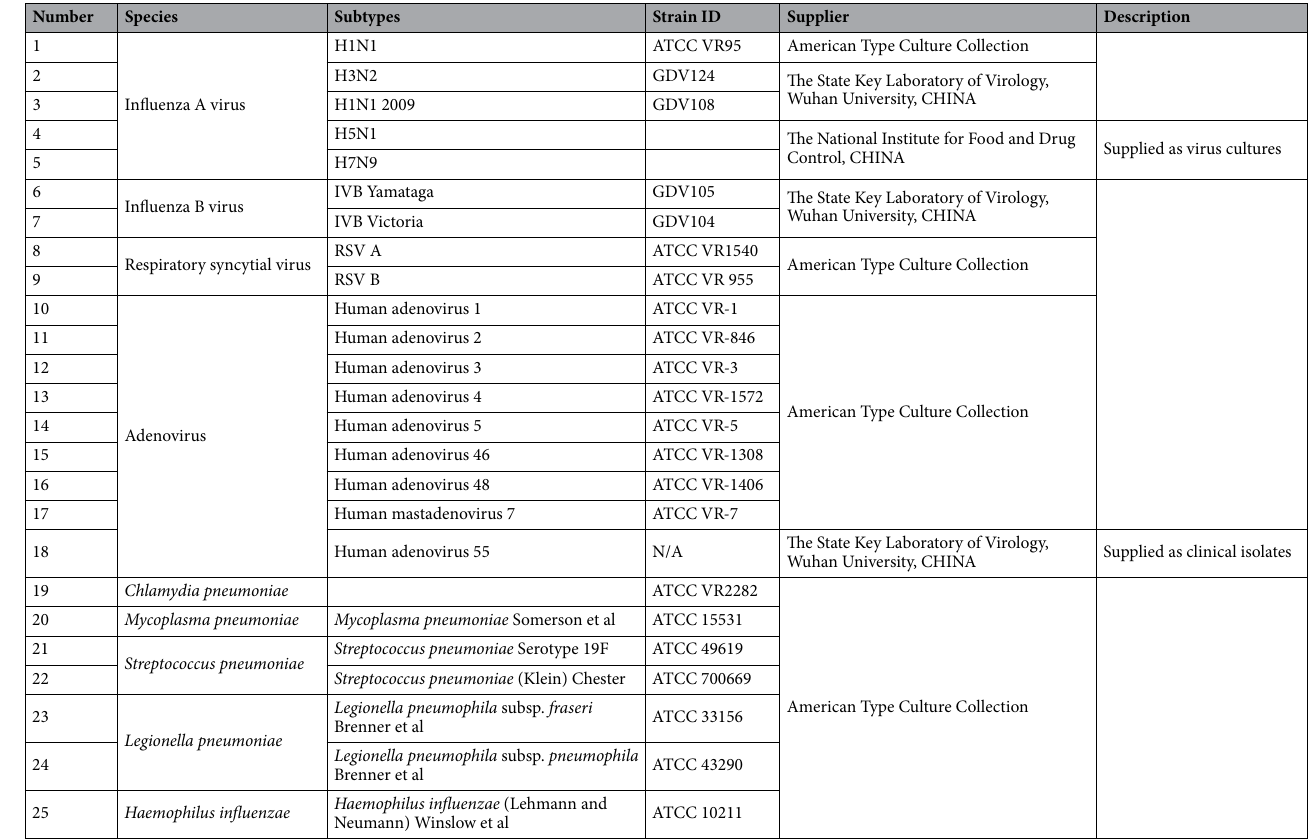
each pathogen to be the target of PCR amplification. The primer and probe design principal for the multiplex